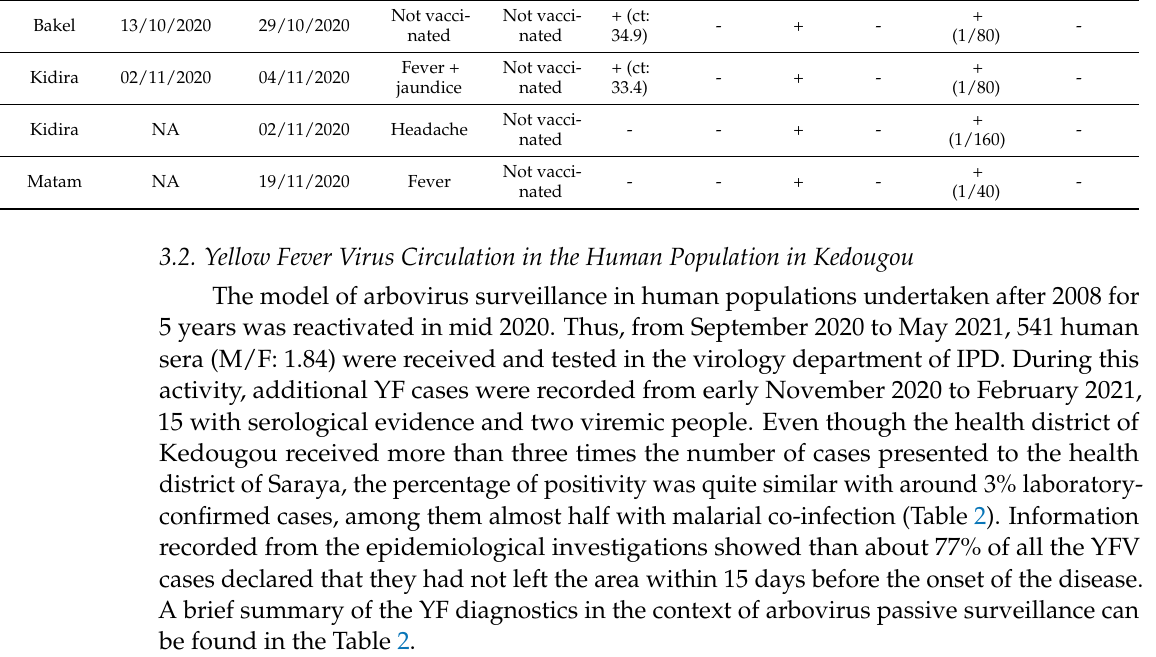
Age Sex Locality